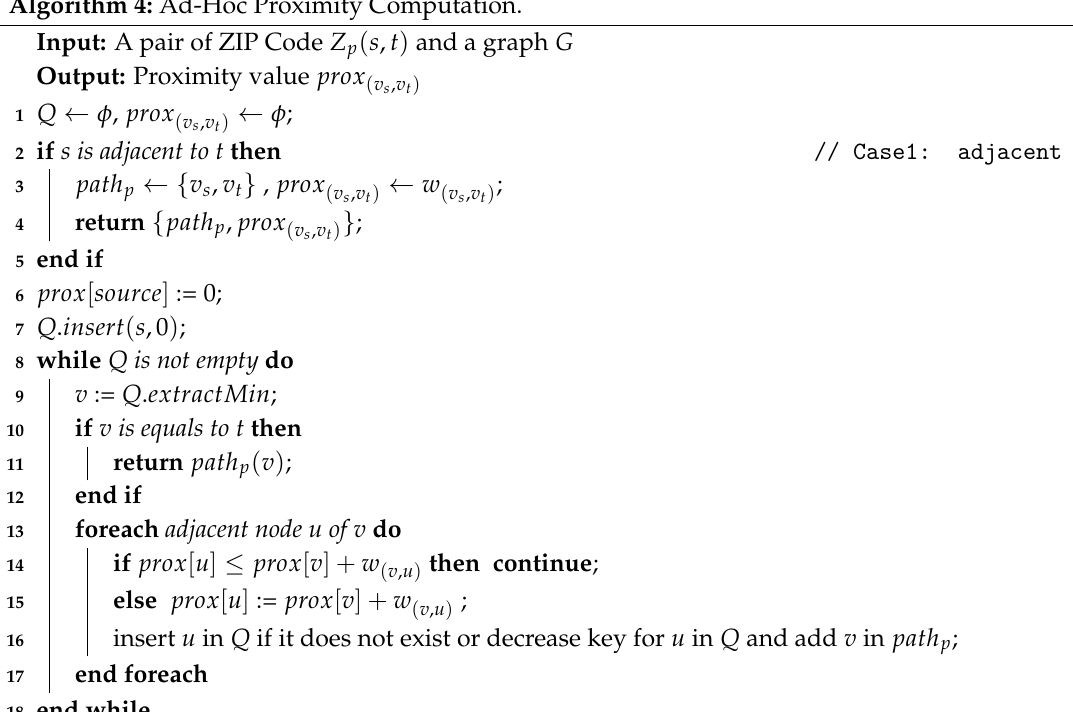
Algorithm 4: Ad-Hoc Proximity